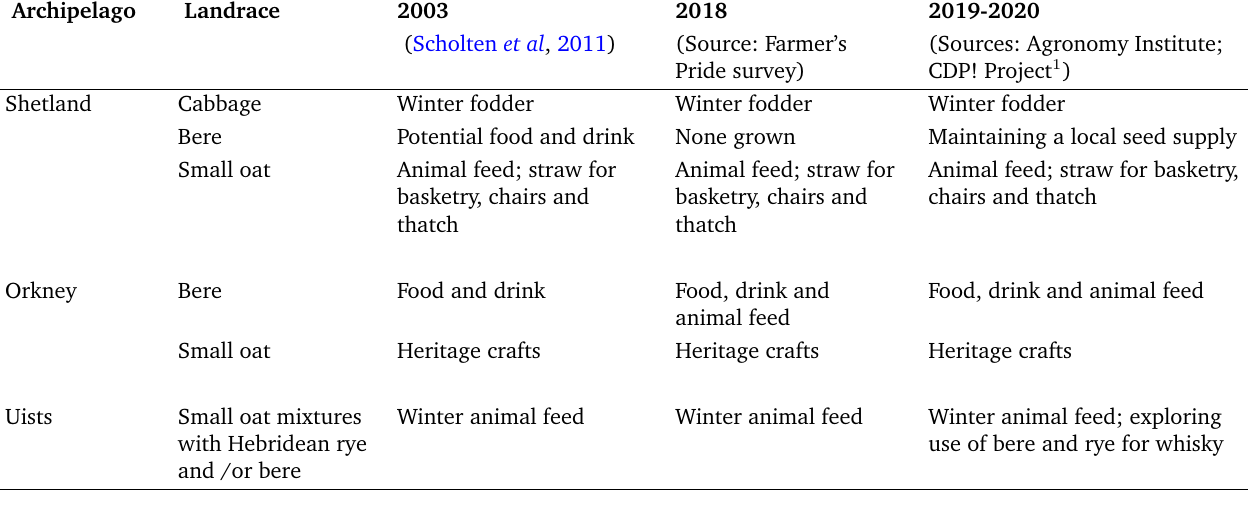
Table 1. Landrace species and their uses documented between 2003 and 2020 in the different Scottish archipelagos.